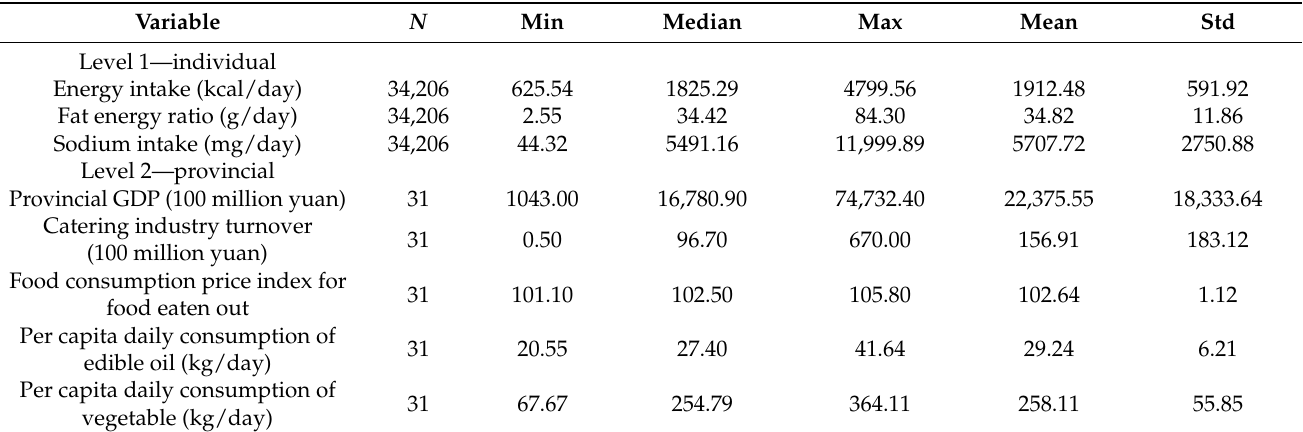
Table 2. Data distribution and assignment of continuous